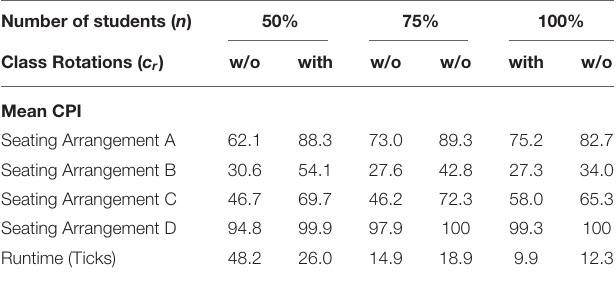
TABLE 7 | List of CPI and the number of runtimes for the four seating arrangements A, B, C, and D with the transmission rate of 0.10, the number of initially infected individuals at 0.10, varying number of students and allowing class rotations. Number of students ( n